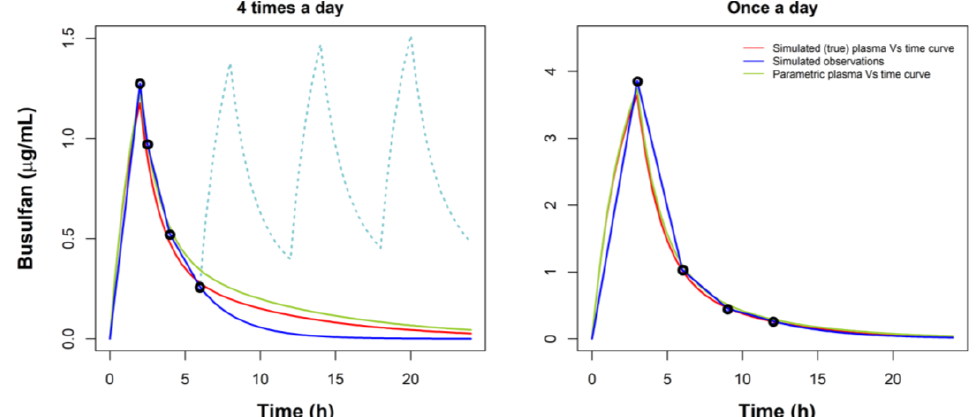
Figure 4. Two representative simulated patients with 3 different approximations in the AUC calculations. Red line represents the true AUC, considering the true PK parameters obtained in the simulations; blue line represents the trapezoidal AUC, considering the simulated observations; green line represents the Bayesian AUC, considering the PK parameters obtained after the Bayesian approach.